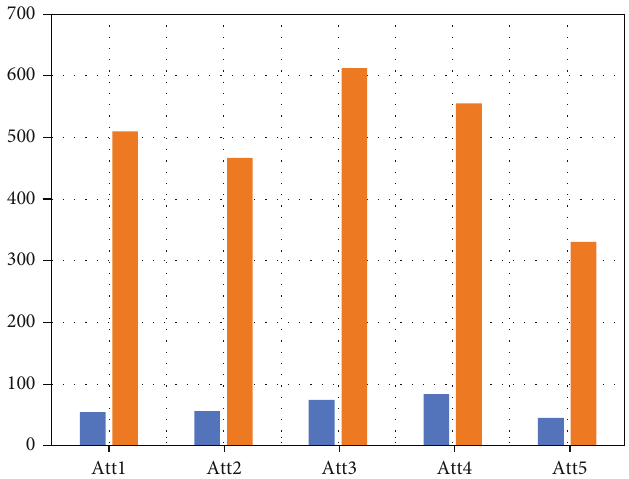
Figure 1: Reading quality and speed toward each